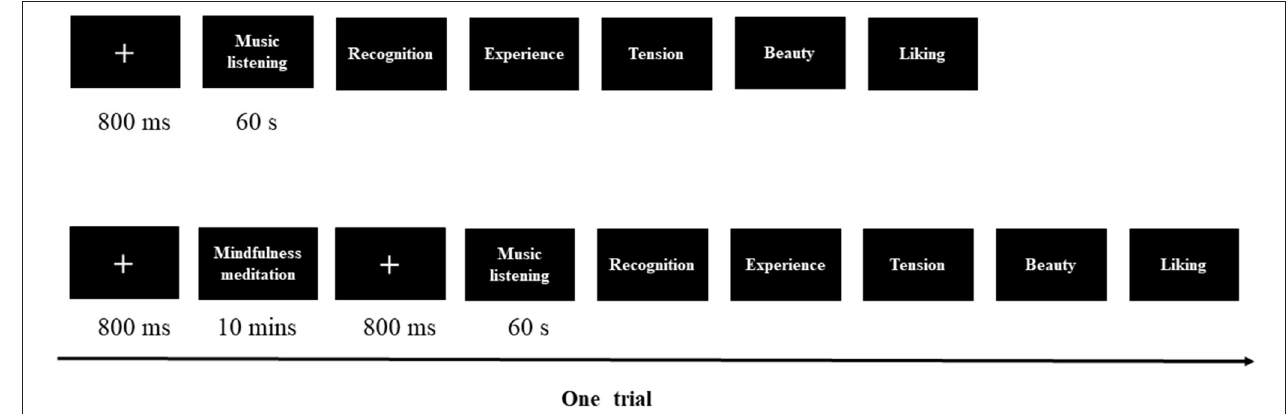
FIGURE 1 | An example of a music aesthetic